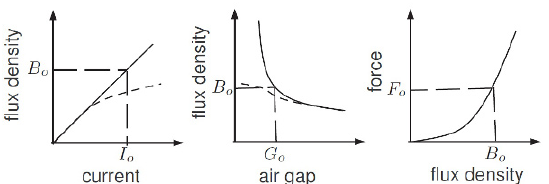
produced by the electromagnet to maintain the carriage at the operating position.